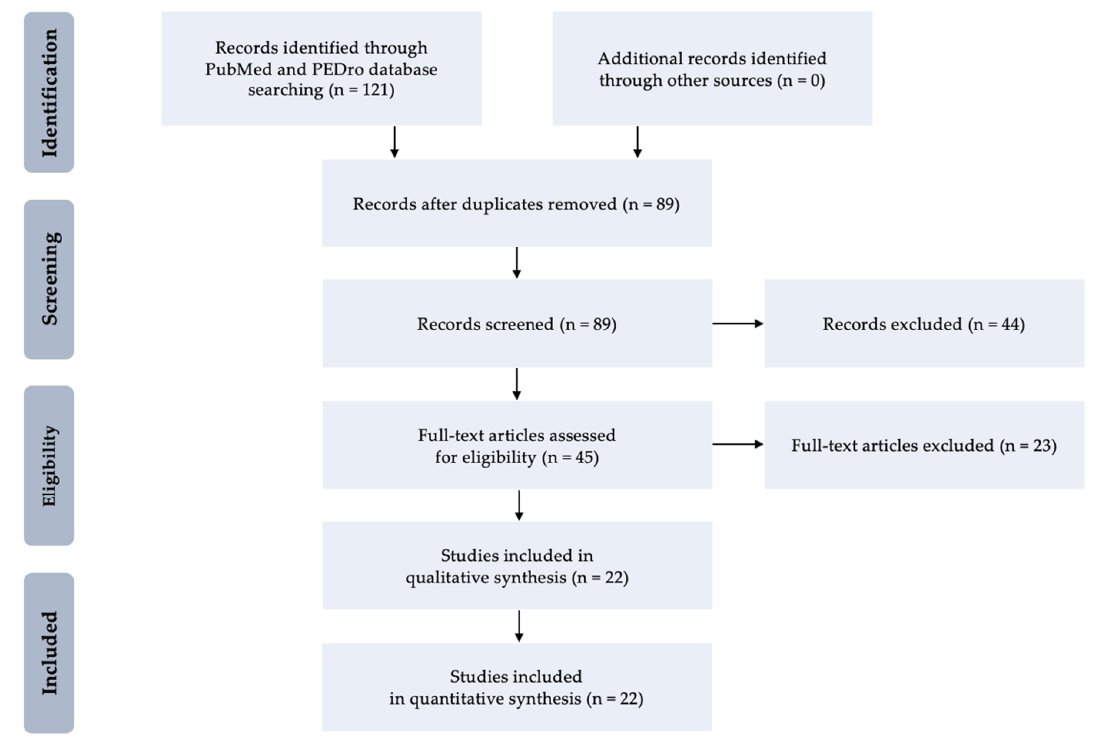
Figure 1. Flow diagram for selection process and identification of studies for inclusion.